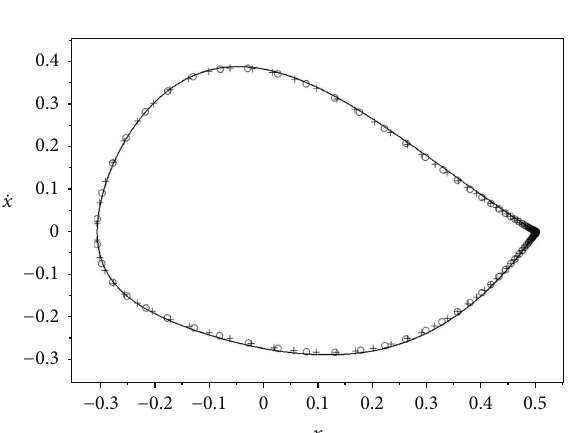
Figure 3: Time histories for homoclinic solutions of (48): — AUTO numericalmethod[30,31]; I I I presentmethod; +++ generalized harmonic function perturbation method [20].